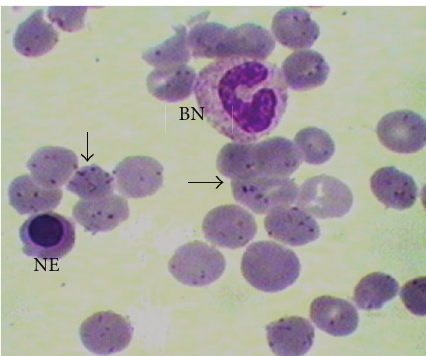
Figure 1: Blood smear of patient in acute phase. Parasitized erythrocytes by bacillary and coccoid forms of B. bacilliformis (arrows), a nucleated erythrocyte (NE), and a band neutrophil (BN) can be observed. Giemsa stain,